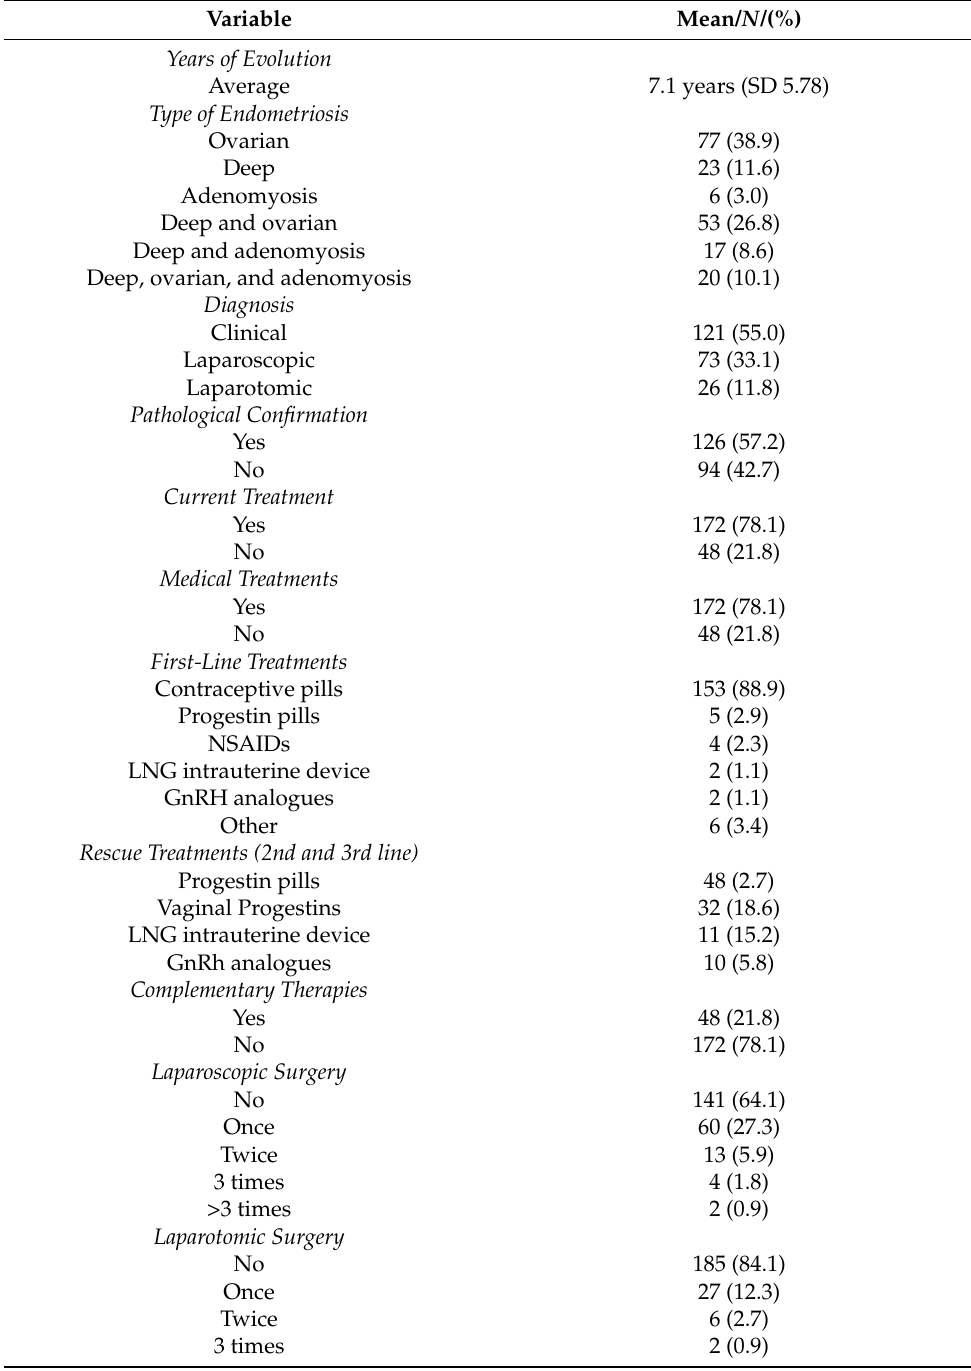
Table 2. Clinical